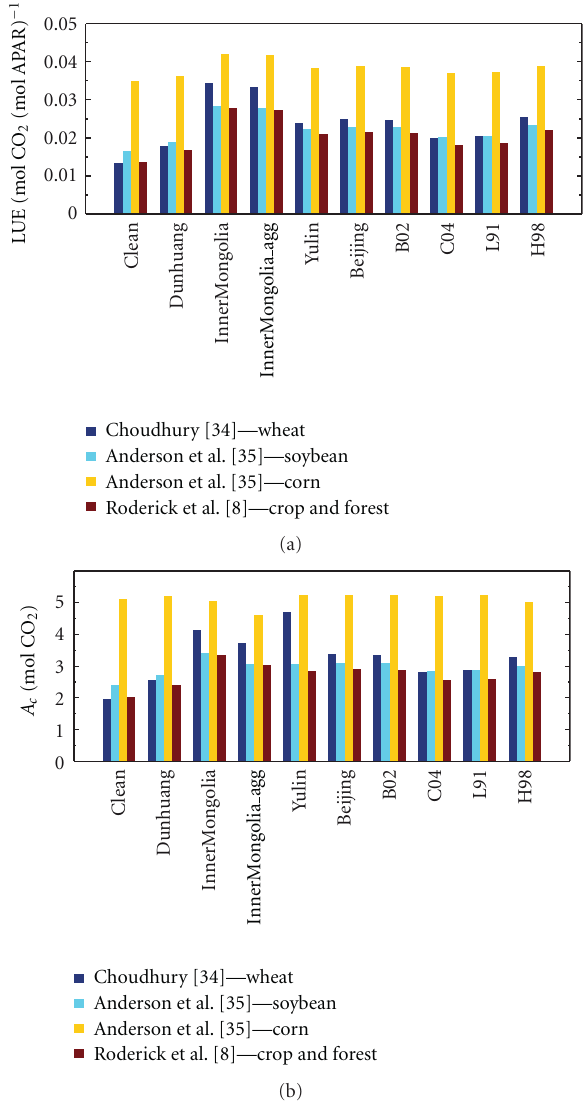
Figure 11: (a) Light use e ffi ciency (LUE), and (b) carbon assim- ilation rate ( A c ) computed for clean and dust conditions (sun elevation angle = 90 ◦ ) using the LUE models of [8, 34,